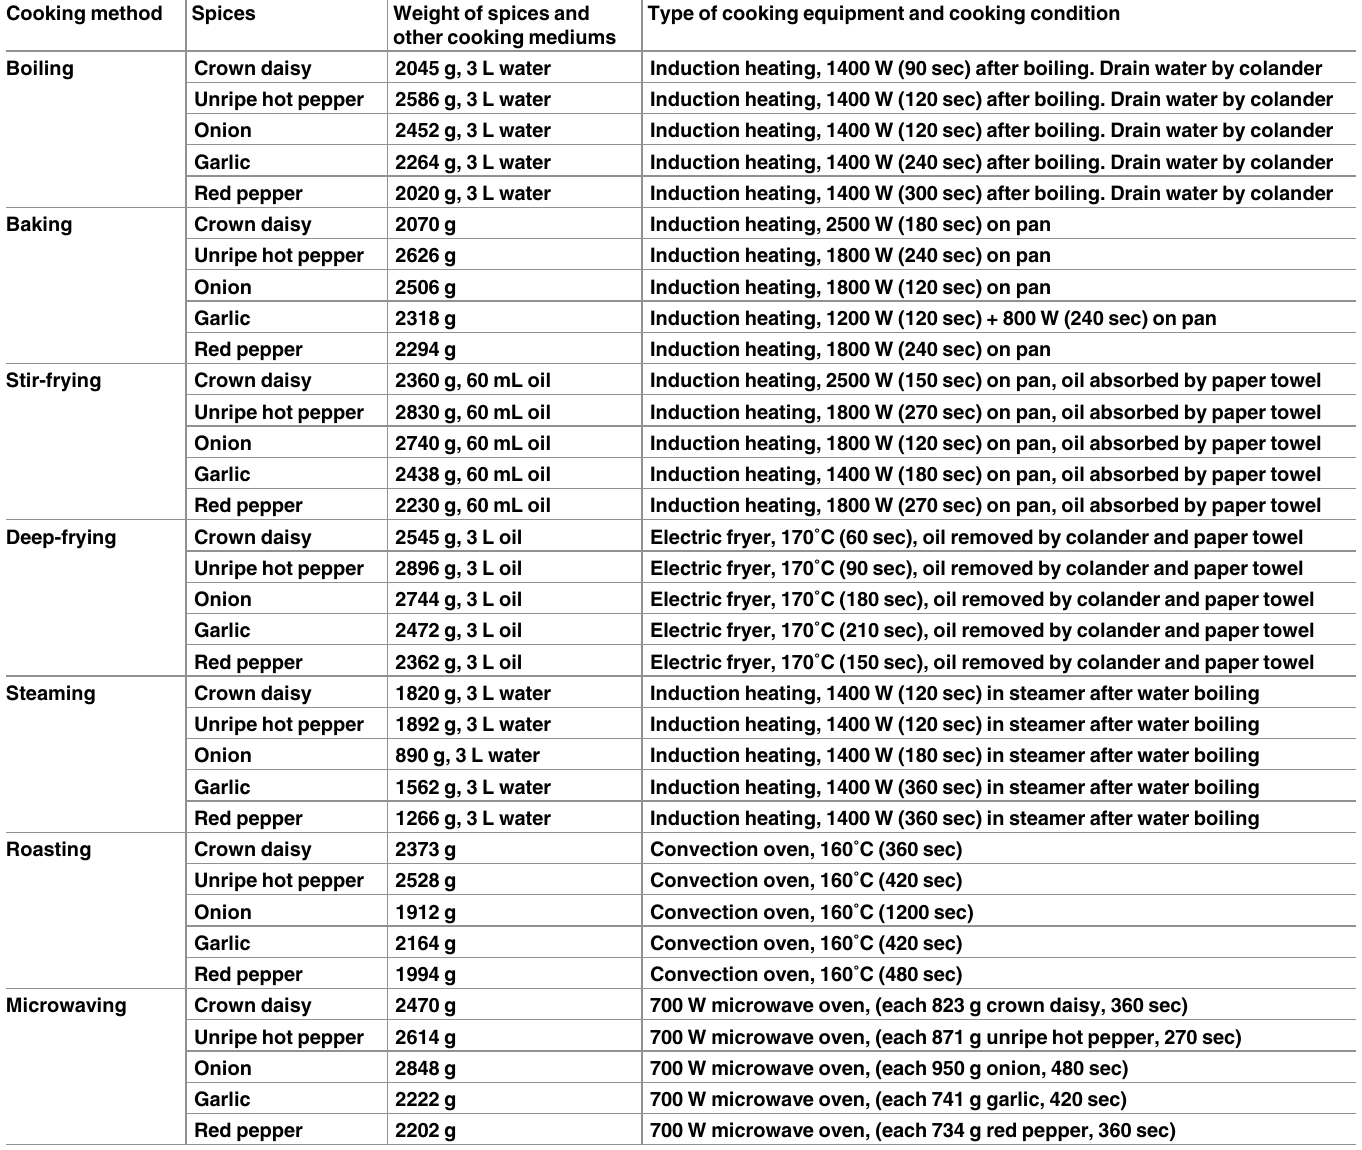
Table 1. Conditions of different cooking procedures for 5 different